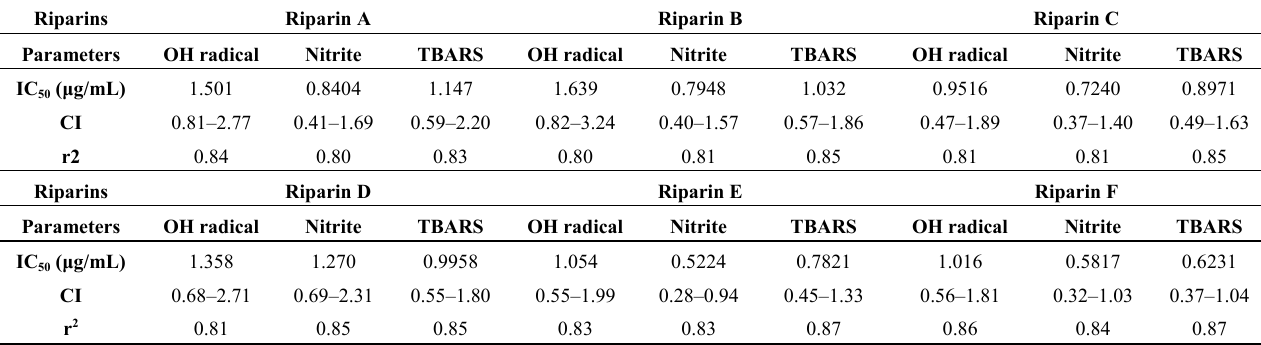
Table 4. IC of in vitro antioxidant potential of riparins A, B, C, D, E and F in TBARS 50 production, (OH) hydroxyl radical content and nitrite